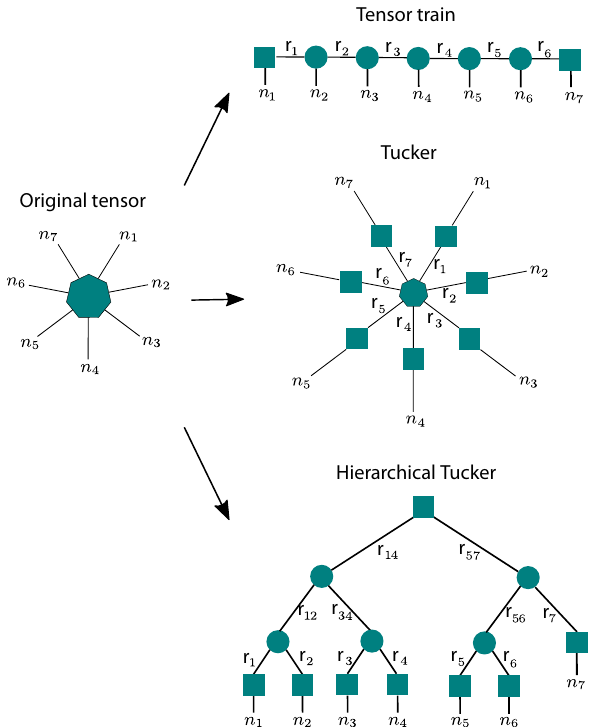
Figure 1. Decomposition of an original input tensor (left) using: Tensor train (top), Tucker (middle), and Hierarchical Tucker algorithm. A heptagon symbolizes a 7-dimensional tensor, a circle encodes a 3-dimensional tensor, and a square encodes a matrix.